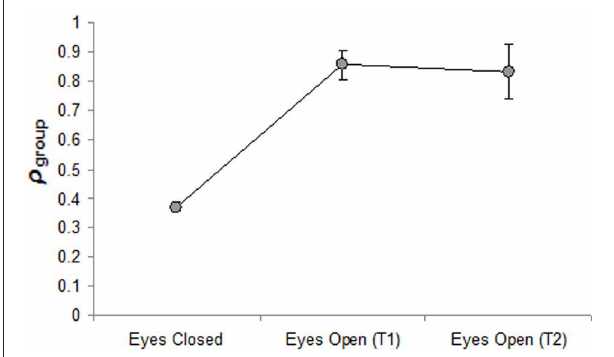
FIGURE 3 | Mean group synchrony, ρ group , as a function of condition and trial (T).